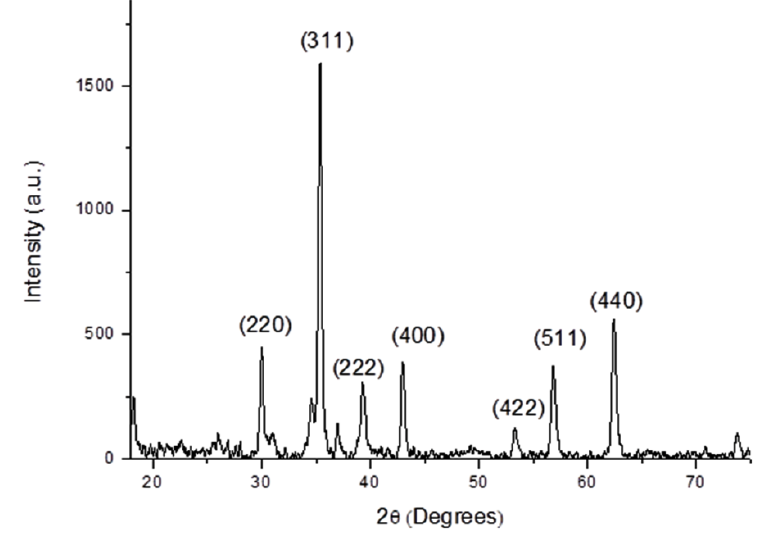
Figure 2. X-ray powder diffraction (XRD) pattern of initial CoFe 2 O 4